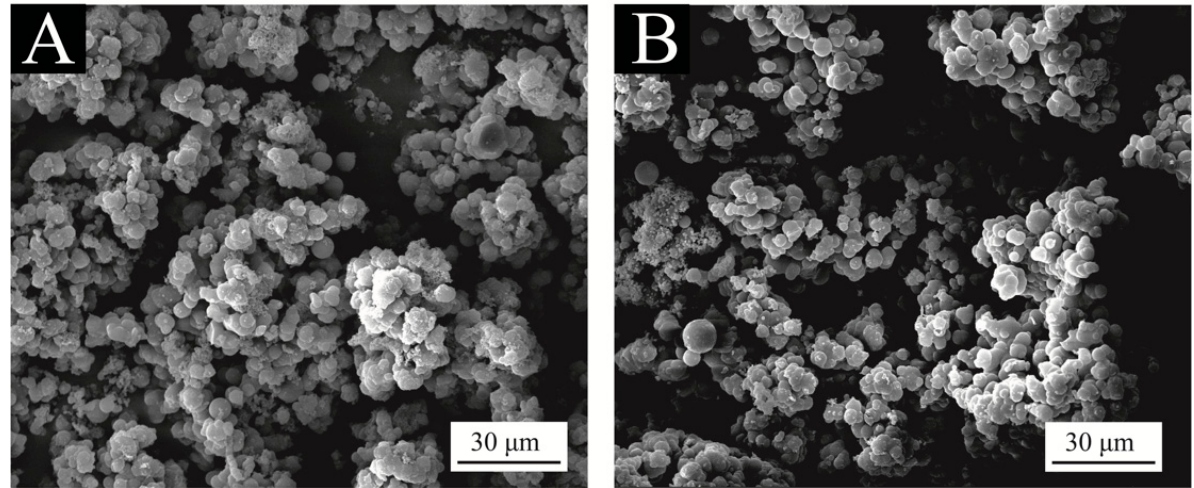
Figure 1. SEM morphology of microcapsules: ( A ) without rice husk powder and ( B ) with rice husk powder.